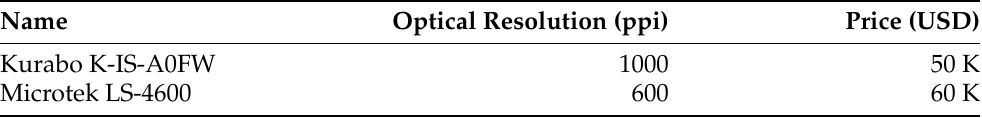
Table A2. Flatbed A0